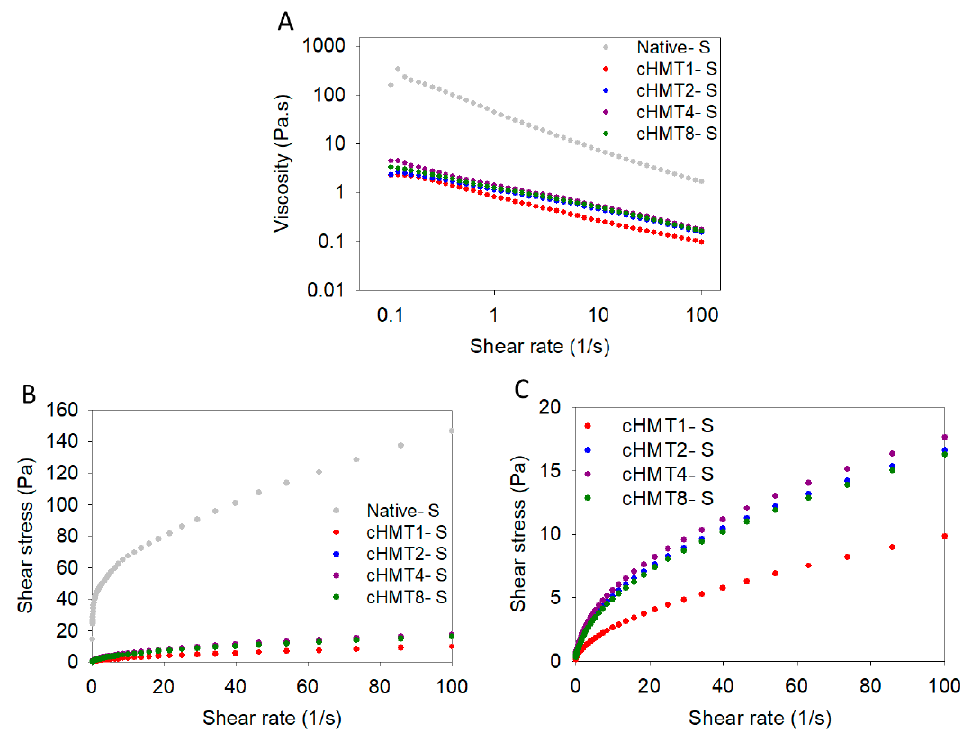
Figure 2. Steady shear rheological properties of native and cHMT water caltrop starch paste. ( A ) Vis- cosity versus shear rate. ( B ) Shear stress versus shear rate of native and cHMT starch. ( C ) Shear stress versus shear rate of cHMT